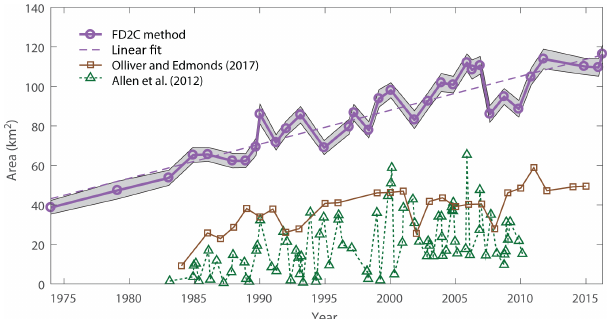
Figure 9. Area of the Wax Lake Delta as a function of time. Pur- ple circles show the growth of the total delta area of the Wax Lake Delta using the FD2C method. The gray region shows the 1 σ devia- tion (16th to 84th percentile) of area found from Monte Carlo sam- pling of (cid:49)l (Sect. 4.1). The dashed line shows the linear fit, with a growth rate of 1 . 72 ± 0 . 13km 2 yr − 1 . Brown squares and greed triangles show the subaerial area as documented by Olliver and Ed- monds (2017) and Allen et al. (2012) over